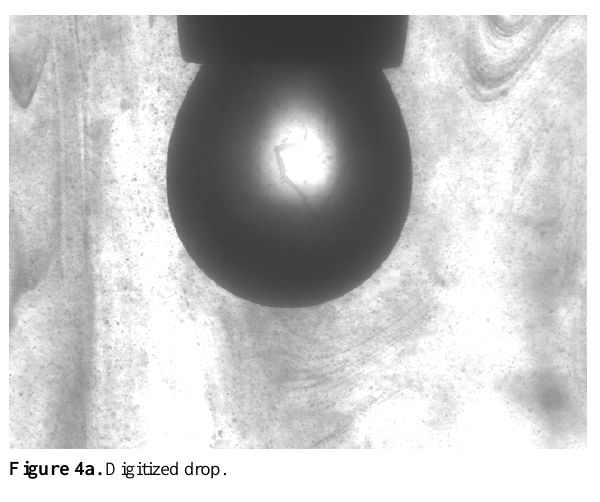
Figure 4c. Smoothed profile.